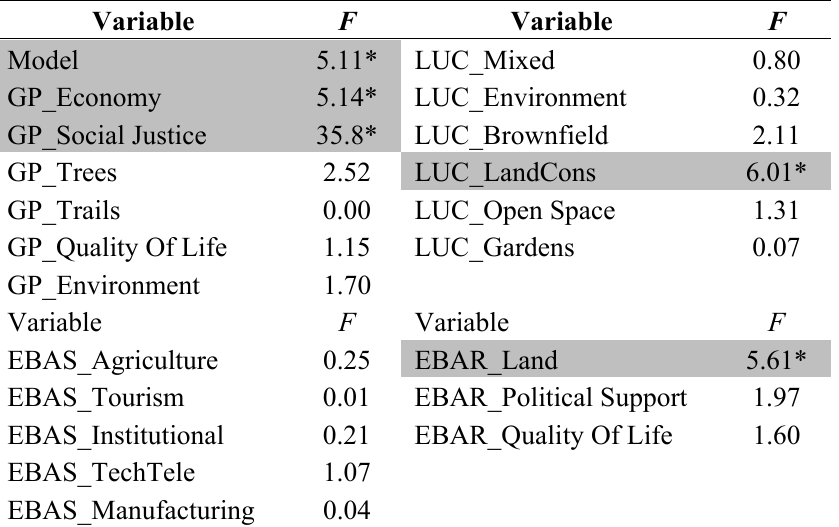
Table 3. Results of ANOVA analysis. Significance (alpha < 0.05) indicated by a * and